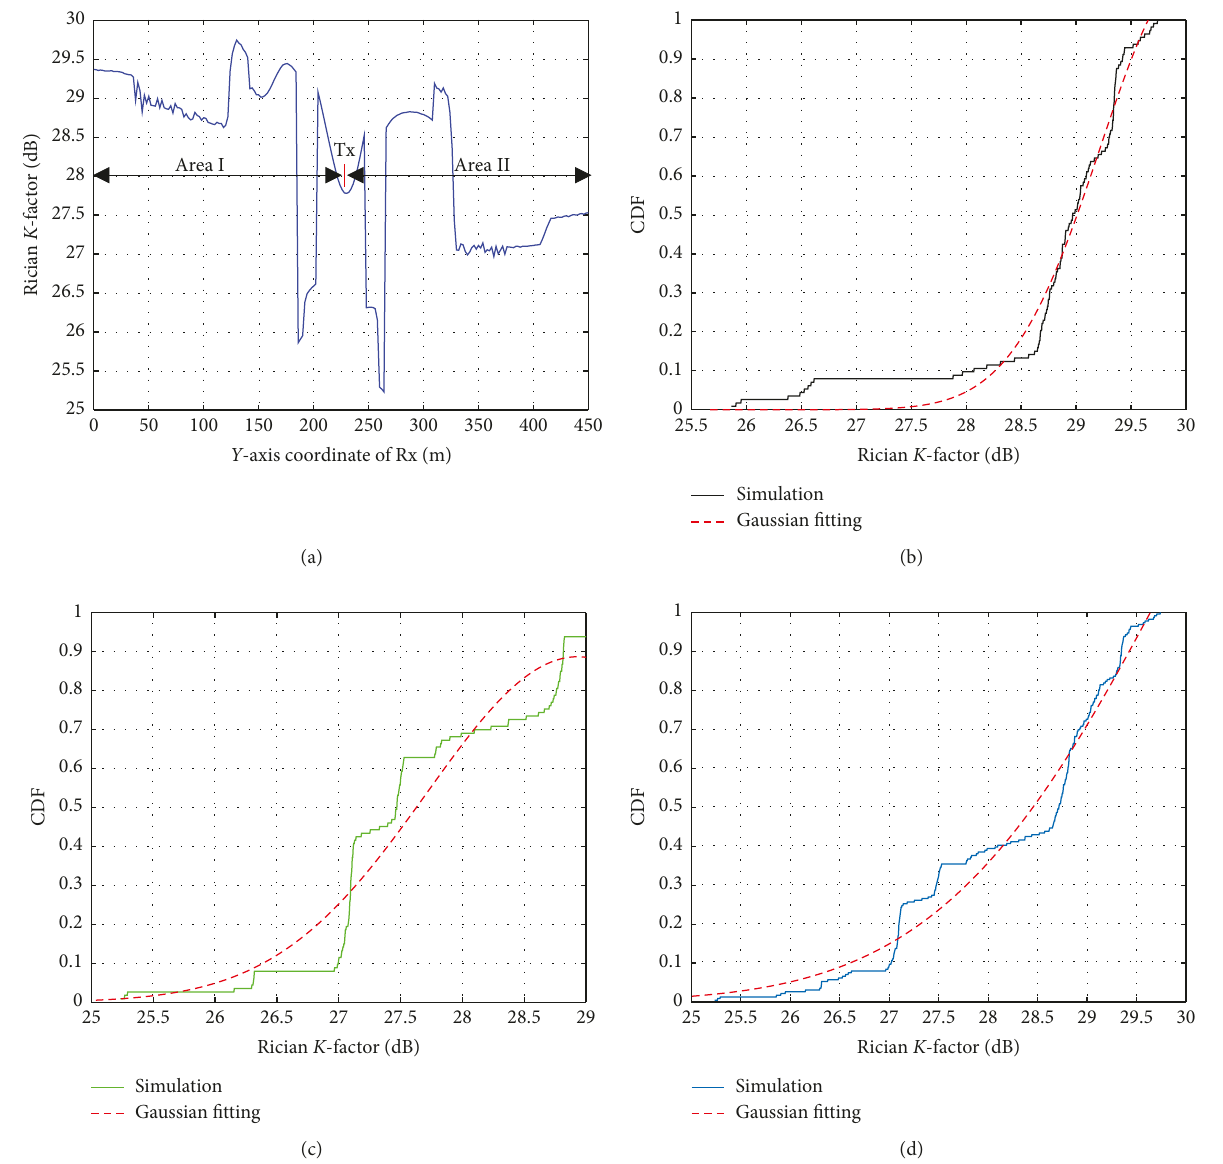
Figure 6: (a) Rician K -factor. (b) Area I. (c) Area II. (d) Line